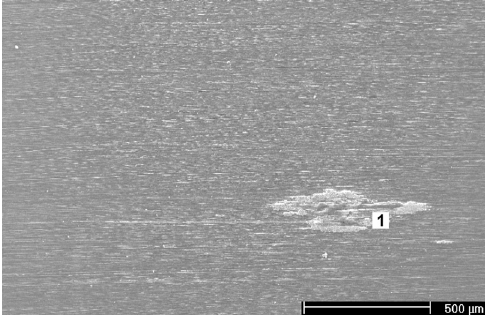
Figure 19. Cross-section of uncoated HCM12A after 336 hours at 833 K in N 2 (cid:3) 100 ppmv SO a) BSE-image. 1) Nickel coating. 2) Cr-rich layer. 3) Sub- strate. b) Corresponding elemental maps for Fe, Cr, O and S.